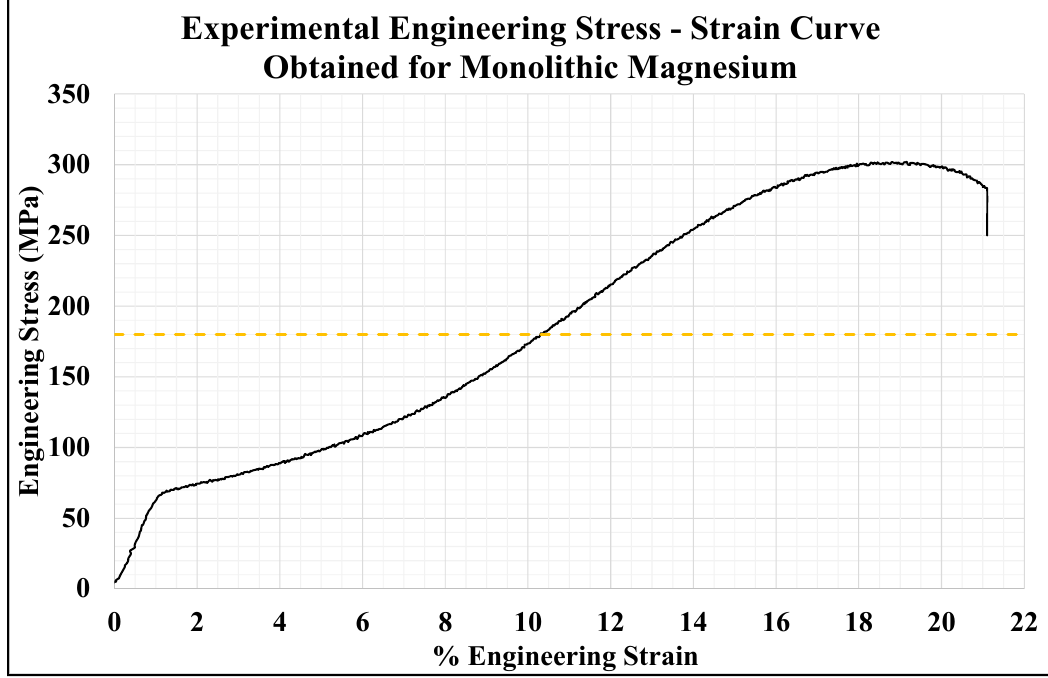
Figure 3. Experimentally obtained Engineering Stress–Strain curve for undrilled monolithic magnesium that was converted to true stress–true strain curve for use in simulations.